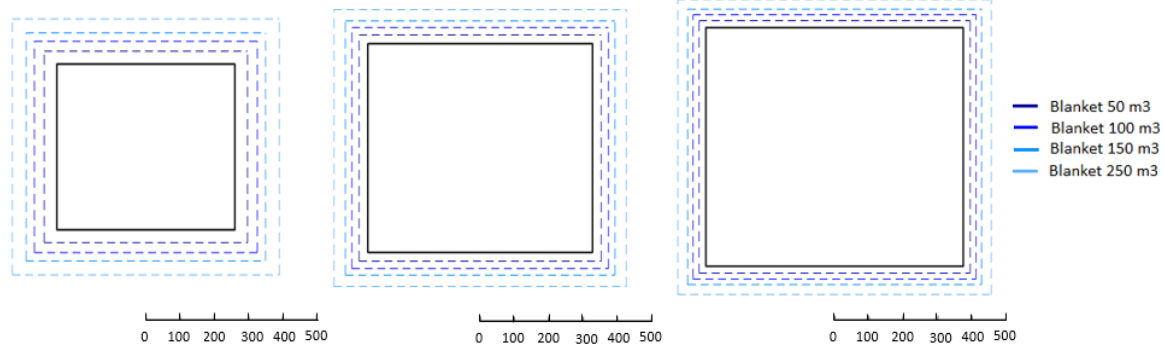
Figure 3. Core and blanket volumes. On scale representation of the core dimensions with different blankets. The core volume is, from left to right, 100 m 3 , 200 m 3 and 300 m 3 . The unit of the scale is